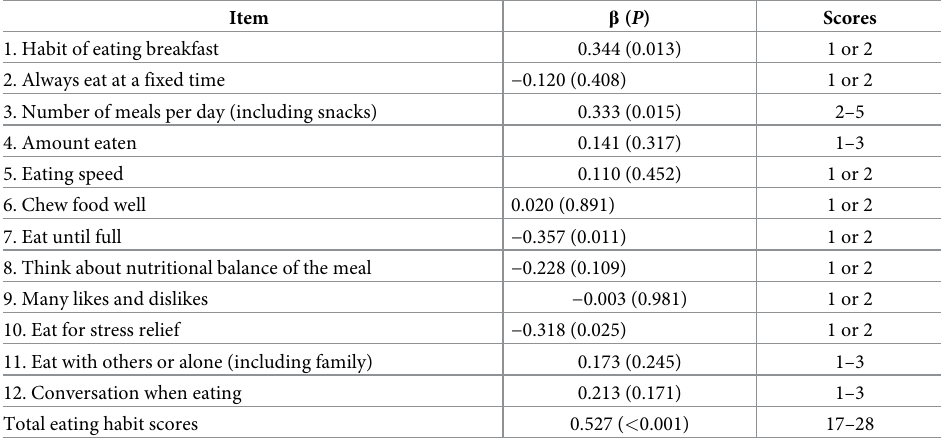
Table 3. Relationship between maximum occlusal force and eating habits and the resulting eating habit